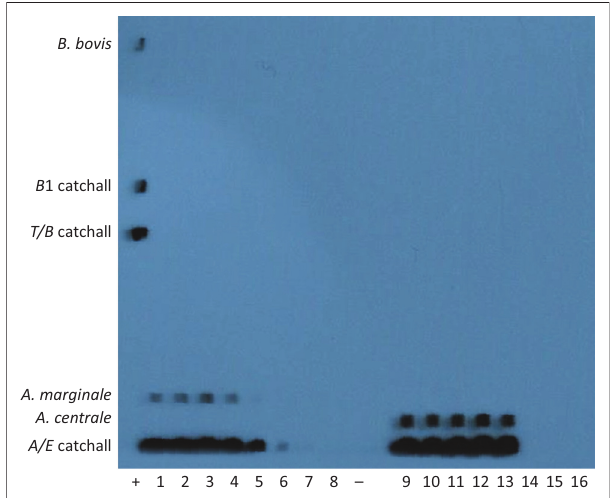
Lanes 1–8: 10-fold serial dilutions of Anaplasma marginale plasmid DNA (clone F48d; Anaplasma marginale 16S rRNA gene). Lanes 9–16: 10-fold serial dilutions of Anaplasma centrale plasmid DNA (clone 9410g; Anaplasma centrale 16S rRNA gene). E/A catchall, Ehrlichia / Anaplasma genus specific probe; T/B catchall, Theileria / Babesia genus specific probe; B1, Babesia 1 specific probe. +, Babesia bovis positive DNA; -, water negative control. FIGURE 1: Detection of serial dilutions (2.5x10 7 – 2.5x10 0 copies) of plasmid DNA by the reverse line blot hybridisation assay.